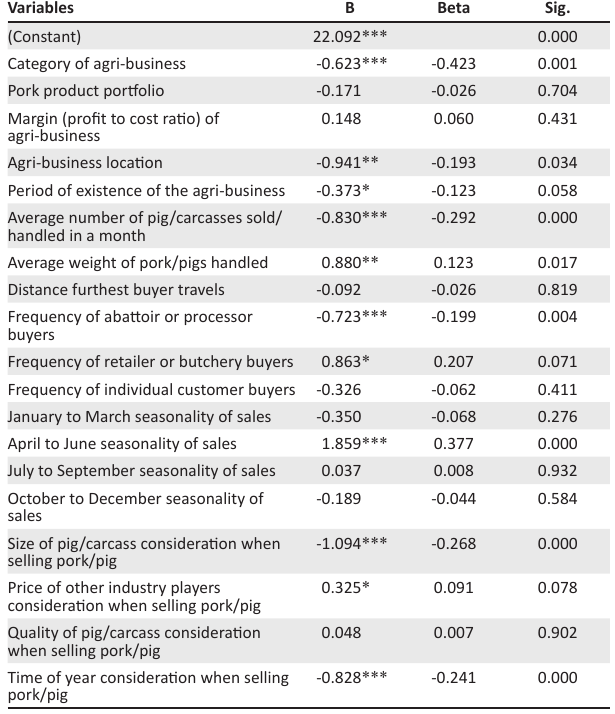
TABLE 4: Empirical multiple linear regression of determinants of perceptive performance of agri-business based on the marketing mix components (perception as total score from Likert